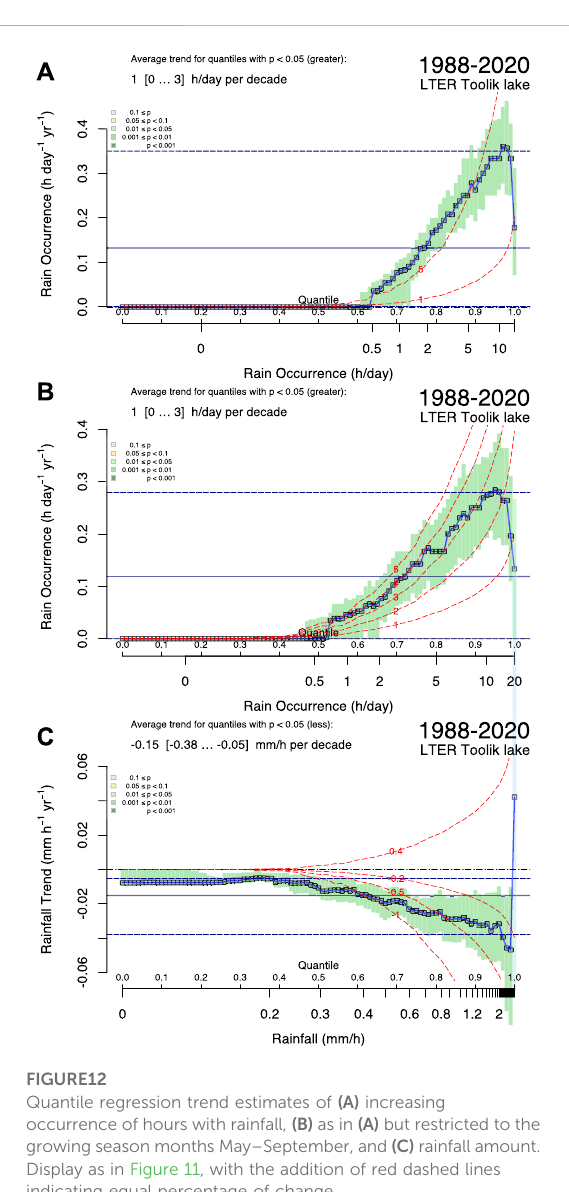
FIGURE 11 Quantile regression trend estimates of (A) lake depth, (B) lake temperature, and (C) horizontal wind speed at 5 m a.g.l. Black squares show the best estimate of the Theil-Sen median trend slope for each percentile of the observed range of quantiles. Color bands show the 95% con fi dence interval of the slope estimate with color coding from green (signi fi cant at p < 0.05 to yellow (marginally signi fi cant, p < 0.1) and light blue for insigni fi cant slopes. The analysis was carried out on gap- fi lled timeseries. For comparison, the best estimates without gap- fi lling are shown with the solid blue line. A signi fi cant downward trend of the lake depth was observed, whereas the warming trend of lake surface waters is only signi fi cant at the lower 45% of temperature observations, that is, winter (under ice) temperatures < 1 – 2 ° C.